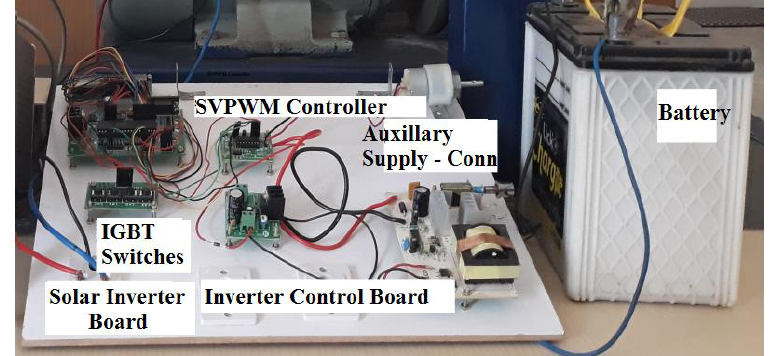
Figure 15. The hardware configuration of the SVPWM-controlled solar inverter. Table 2. Input data for the solar